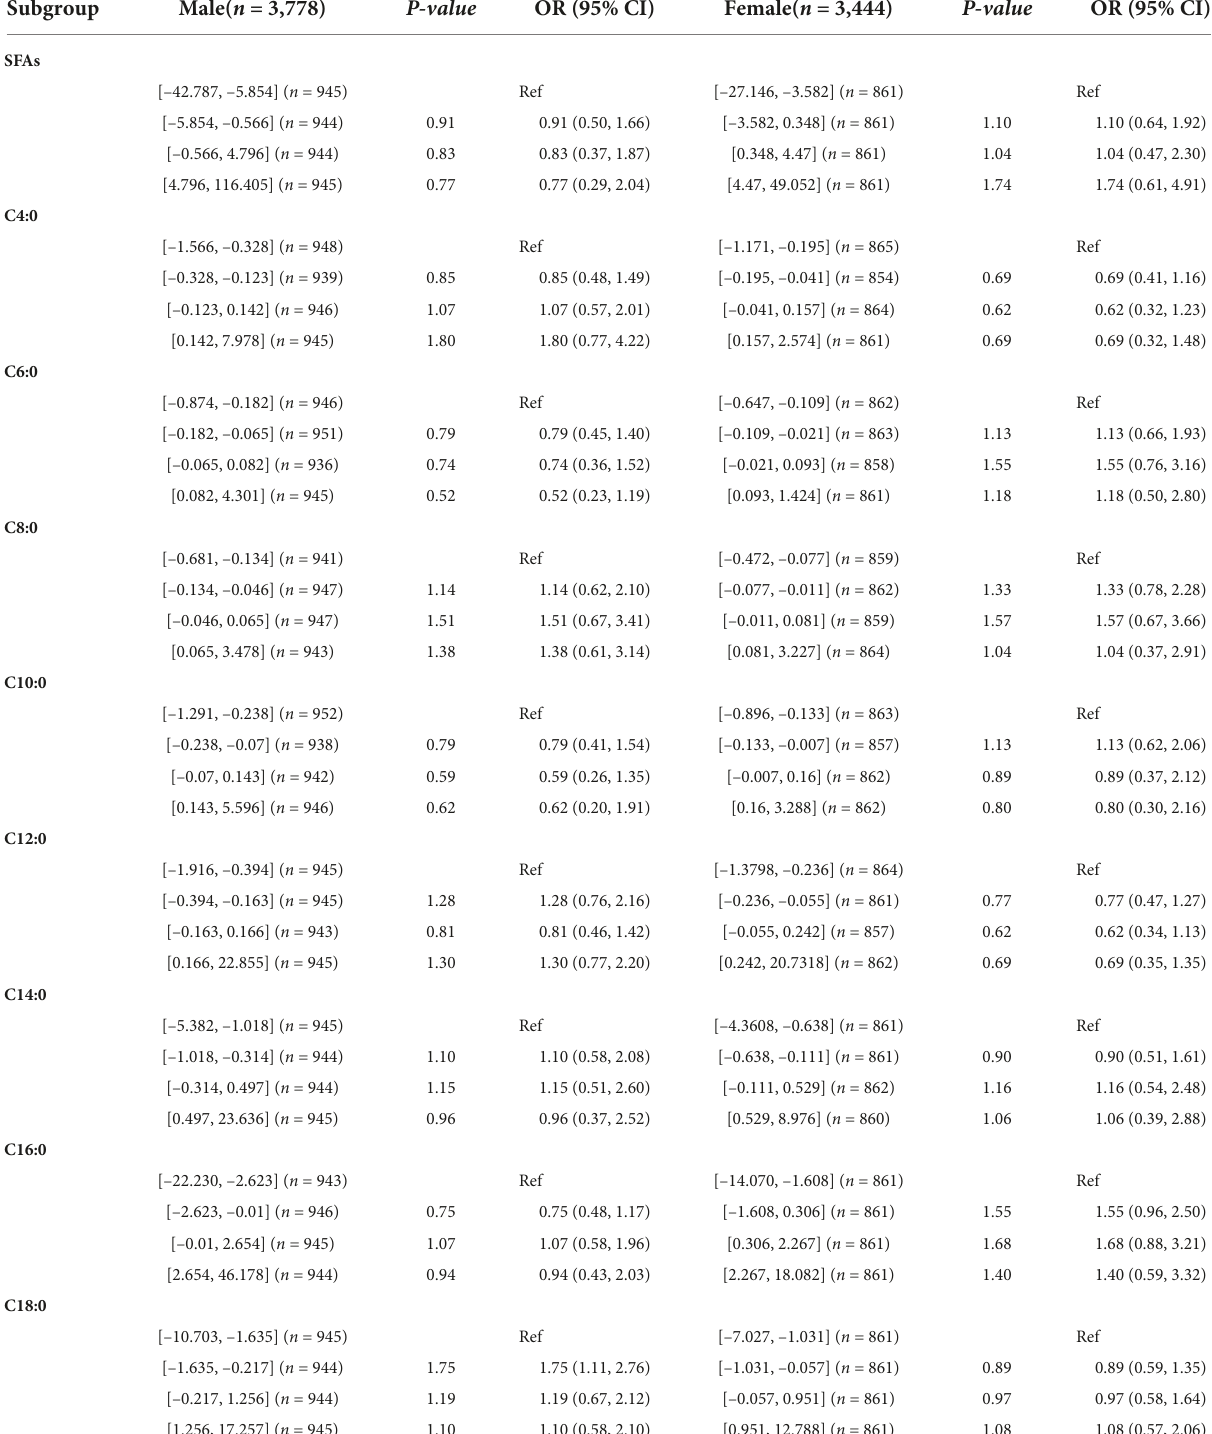
TABLE 6 Weighted OR (95% CI) for hypertension in quartiles of adjusted dietary saturated fatty acid intake stratified by gender in NHANES,